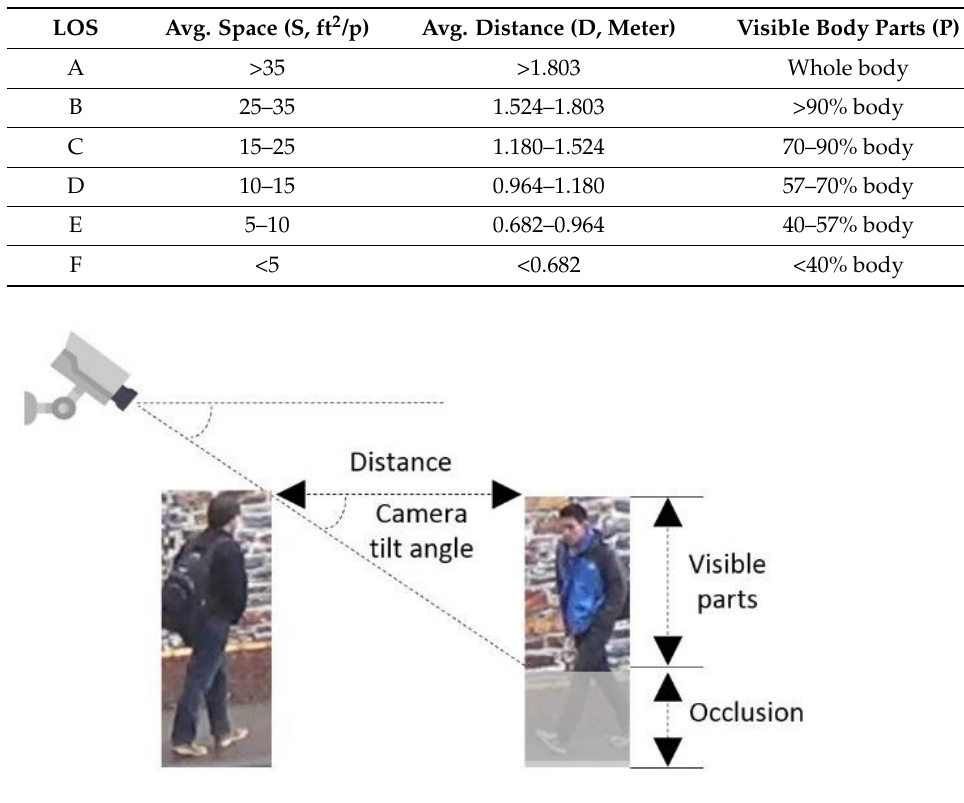
Figure 3. The idea of calculating the percentage of visible body part. Image source: Duke-MTMC dataset.